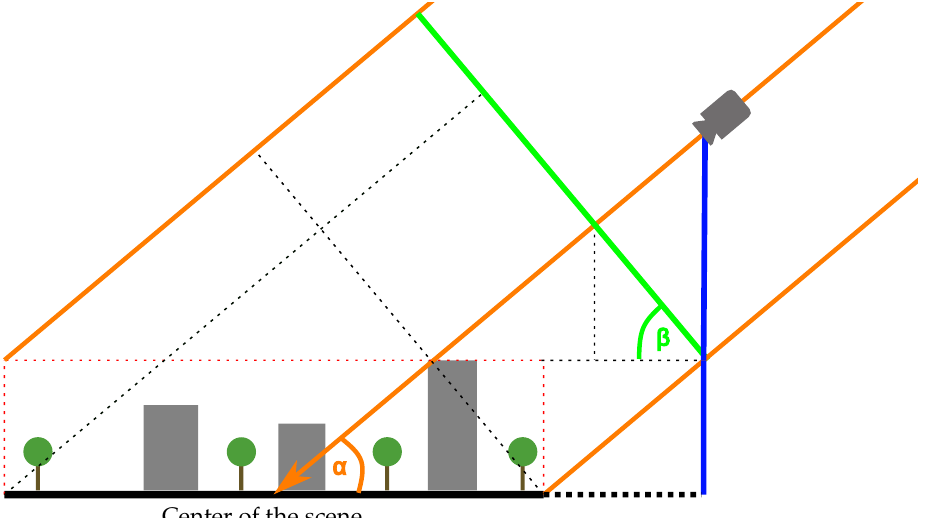
Figure 3. Calculation of orthographic camera properties: height of the render target (green), camera height (blue), based on the scene bounding box (red dashed) and sun altitude angle ( β , °). The scene is drawn according a 40° height angle of the sun. Table 1. Comparison between the geometrical and technical properties of a perspective camera projection and an orthographic camera